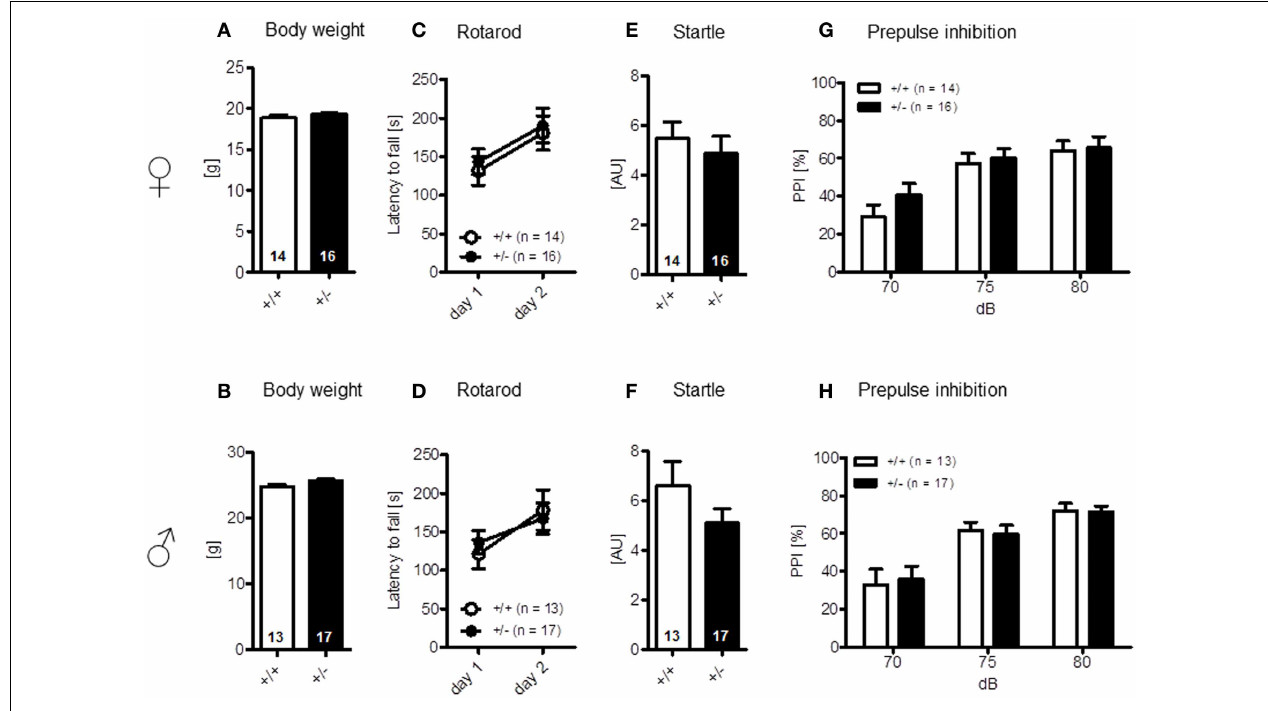
FIGURE 3 | Motor performance and sensorimotor gating of male and female Ambra1 + / − versus Ambra1 + / + mice are normal .The upper row presents results for female, the lower row for male mice. (A,B) Body weight;